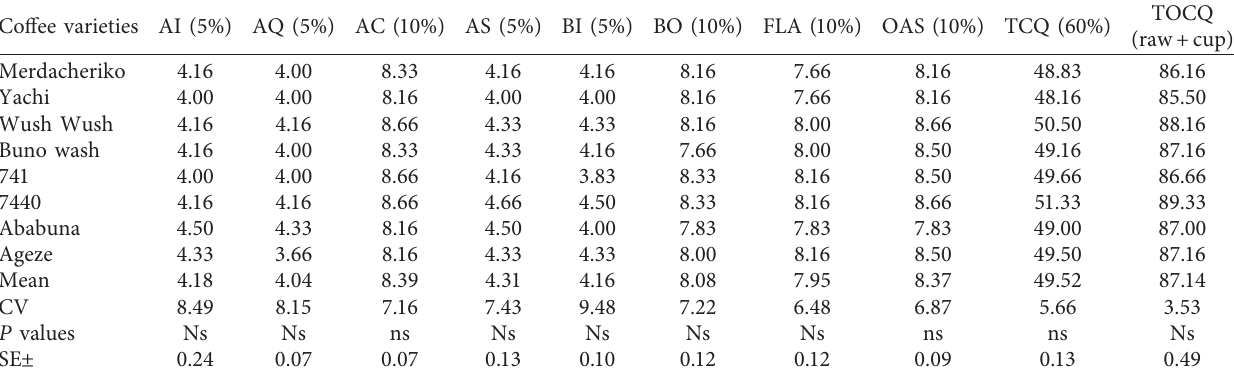
Table 4: Bean cup quality parameters of coffee varieties grown in WARC during 2018 main cropping season.